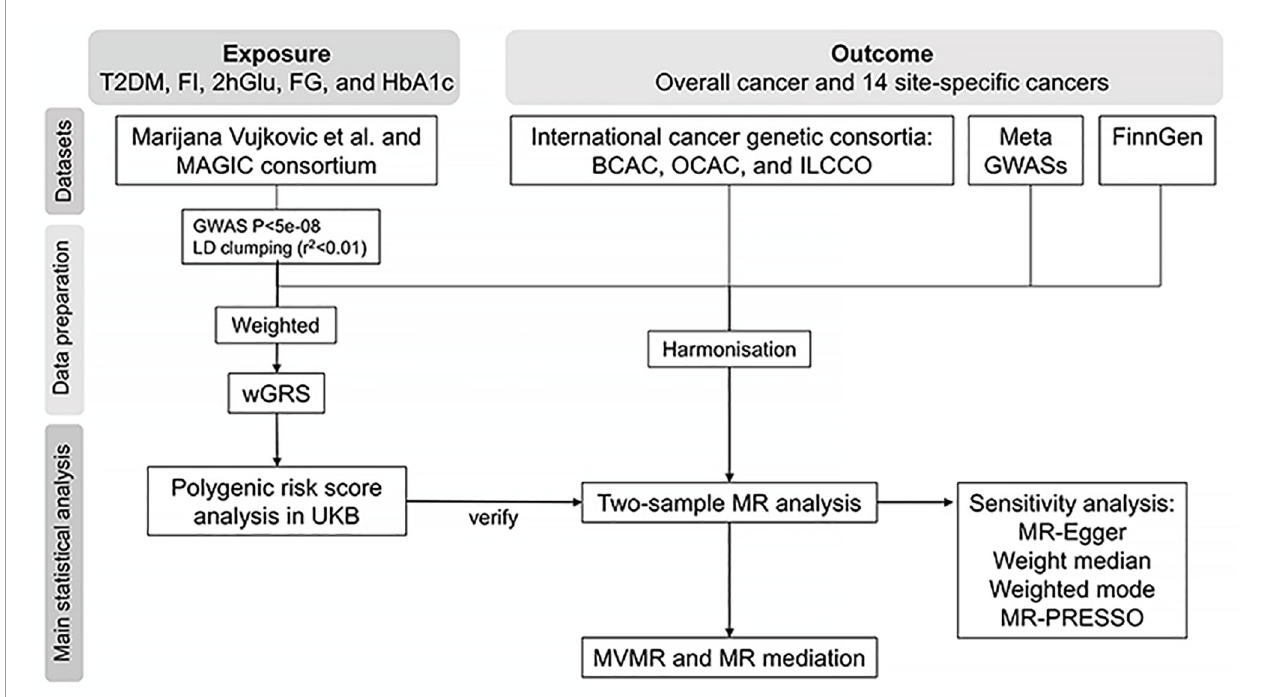
FIGURE 1 | Flowchart of the study. T2DM, type 2 diabetes; FI, fasting insulin; 2hGlu, 2-h glucose after an oral glucose challenge; FG, fasting glucose; HbA1c, glycated hemoglobin; LD, linkage disequilibrium; wGRS, weighted genetic risk score; UKB, UK Biobank; BCAC, the Breast Cancer Association Consortium; OCAC, the Ovarian Cancer Association Consortium; ILCCO, the International Lung Cancer Consortium; MR, Mendelian randomization; MVMR, multivariable